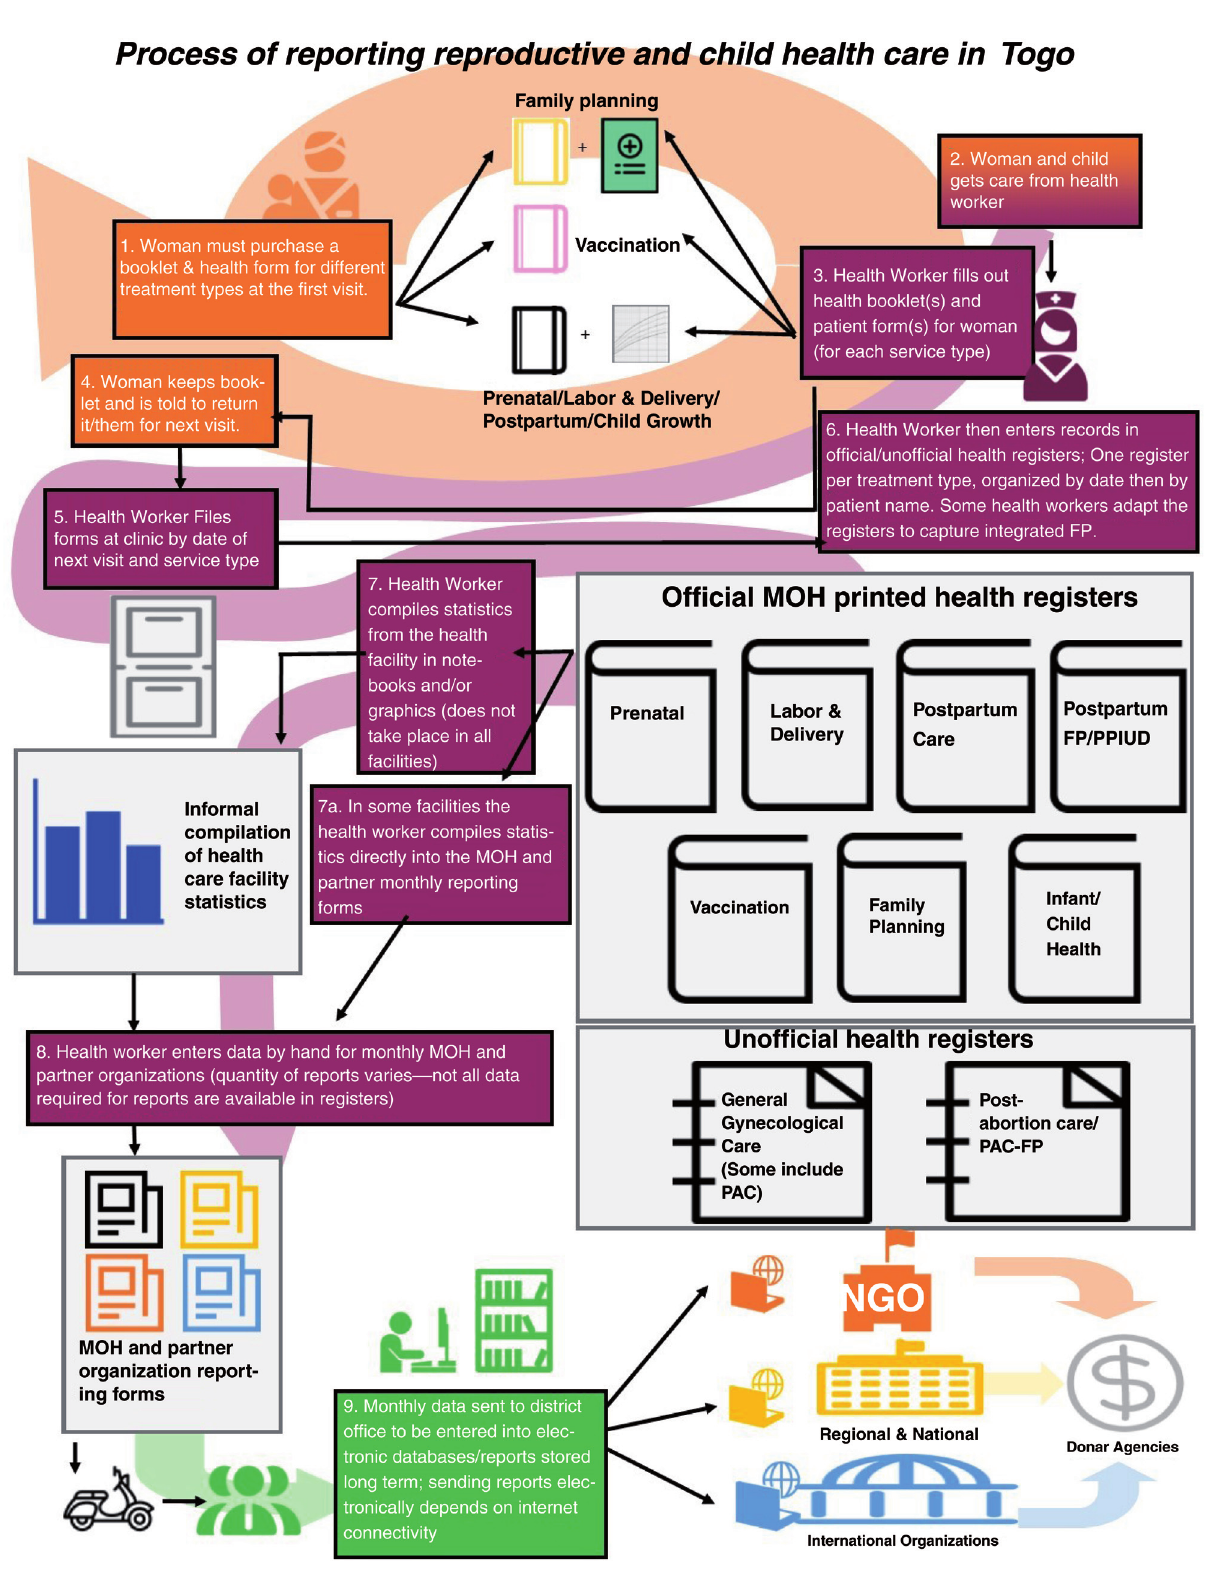
Figure 1. The process of Reporting Reproductive and Child Health Care in Togo. The expected data collection steps and tools used in the reporting process to monitor utilization of integrated family planning services in